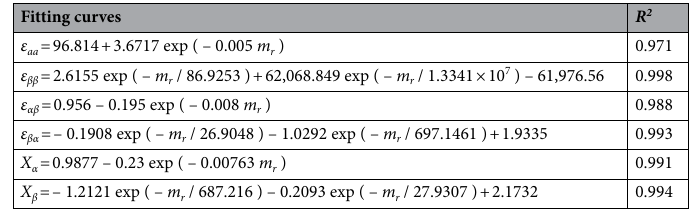
Table 3. Fitting curves of ε aa , ε ββ , ε αβ , ε βα , X α and X β vs . solid mass ( m r , mg).